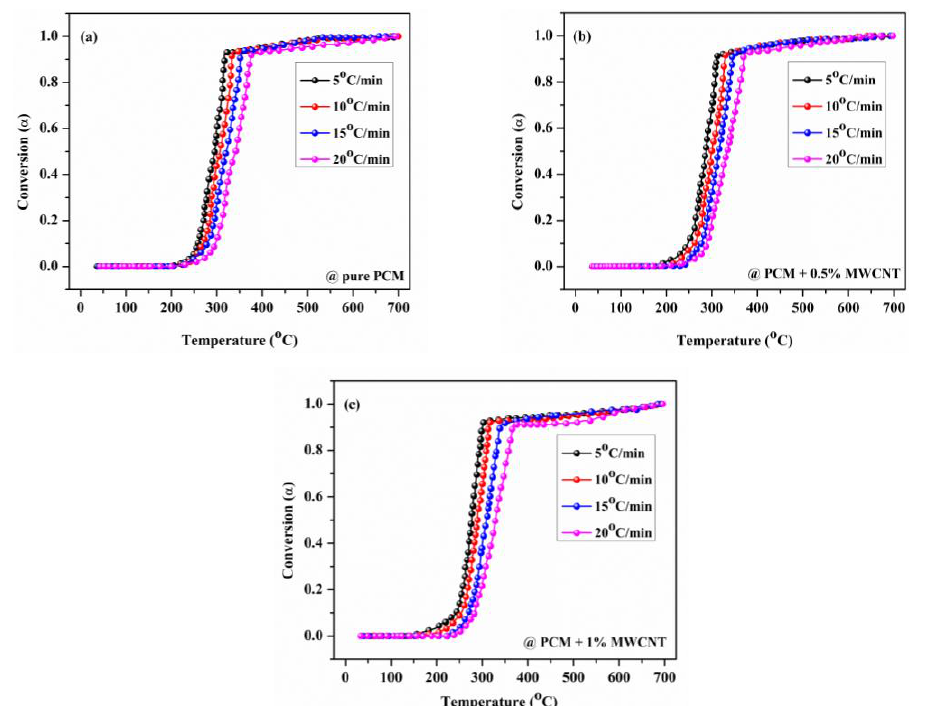
Figure 5. Conversion plots ( a ) pure PCM ( b ) PCM + 0.5% MWCNT ( c ) PCM + 1% MWCNT.